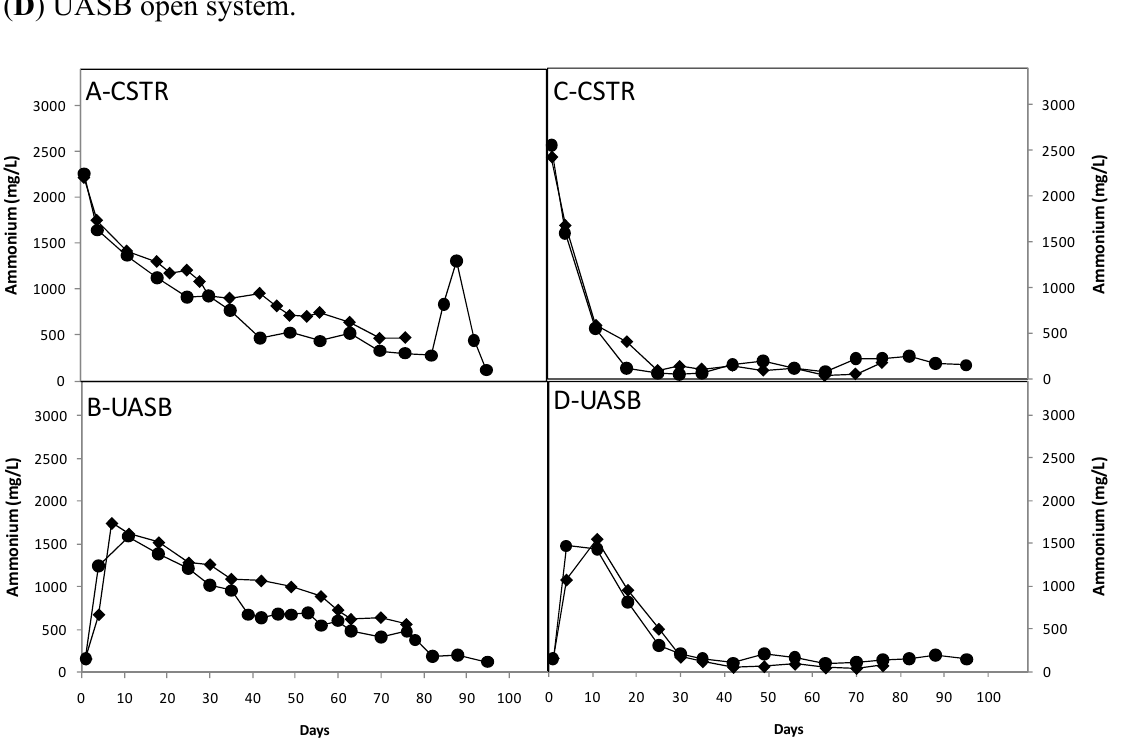
Figure 5. The ammonium concentration during the experimental period. ● - Starch; ♦ - Cotton. ( A ) CSTR closed system; ( B ) UASB closed system; ( C ) CSTR open